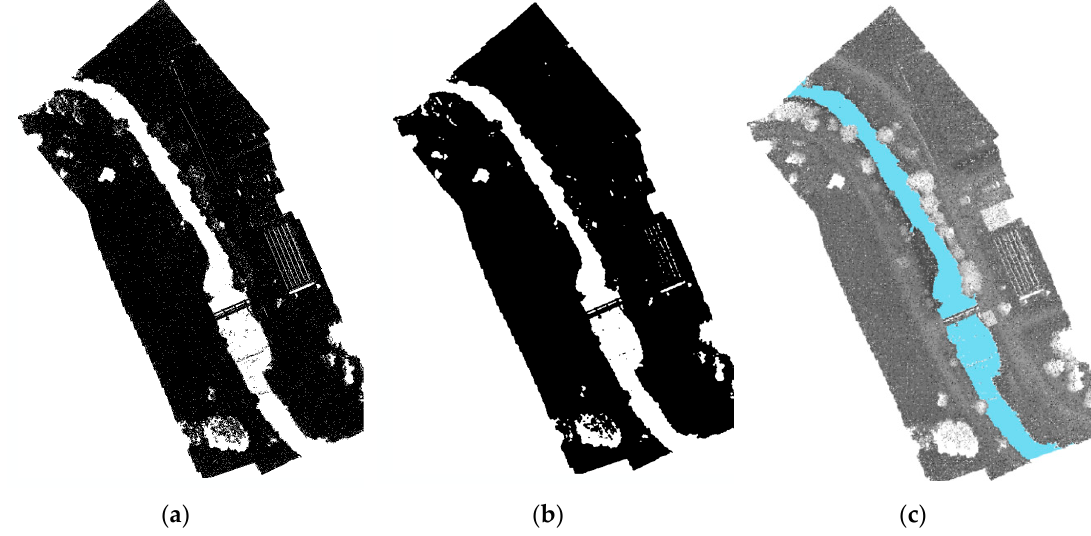
Figure 4. Examples of the processing according to the image transforms strategy: ( a ) the binarization results, ( b ) the class Water after applying the modal filter for the raster format and the conversion into a vector format, and ( c ) the final results of the classification (blue area) filtered using the SQL query and projected over the input